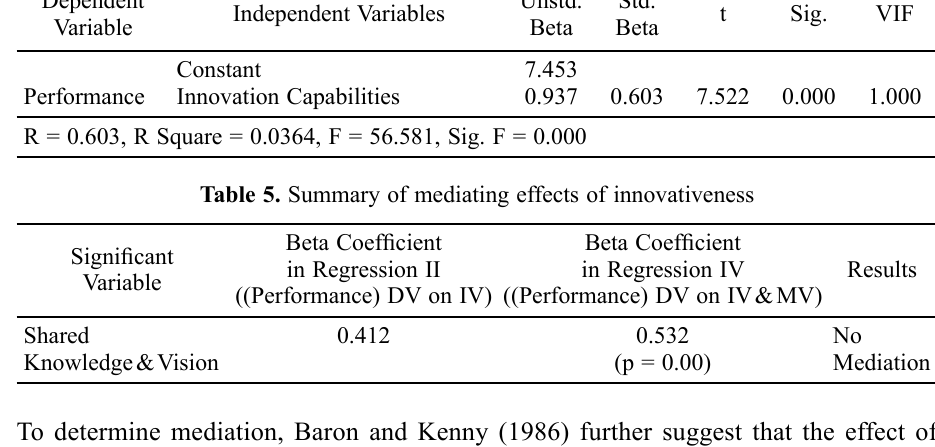
Table 4. Regression anal ysis – the influence of innovation capabilities on performance Dependent